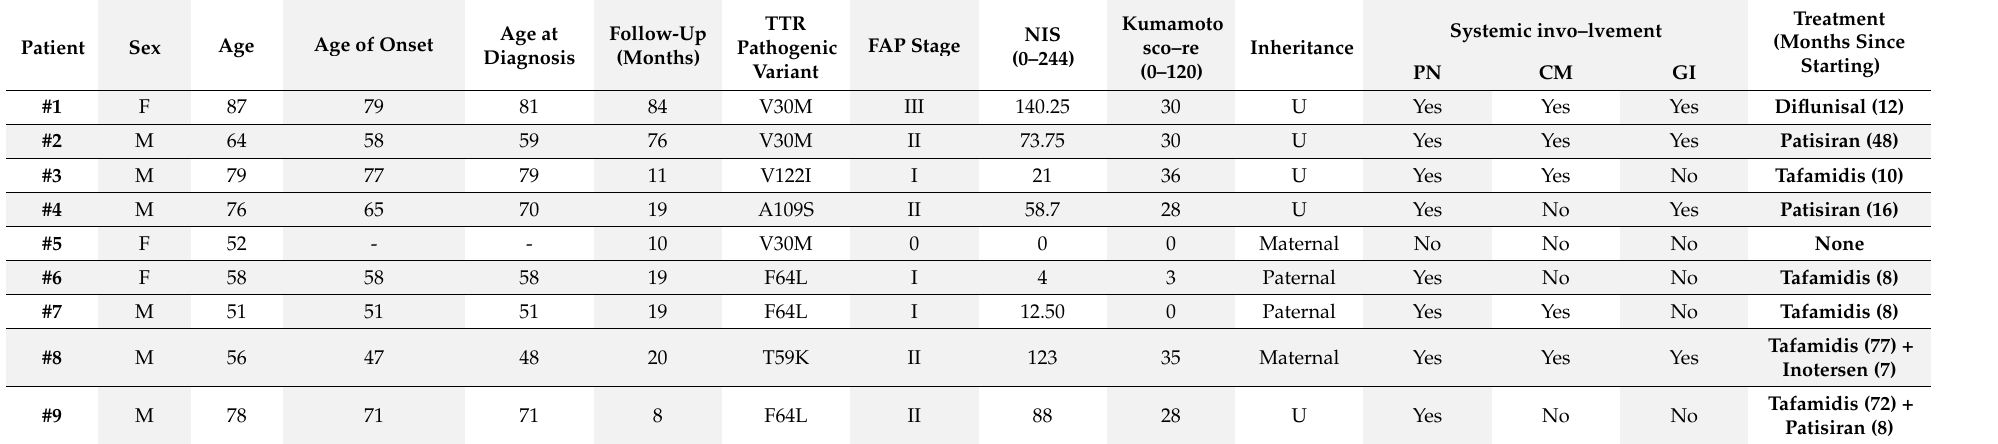
Table 1. Genetic, demographic, and clinical data of the